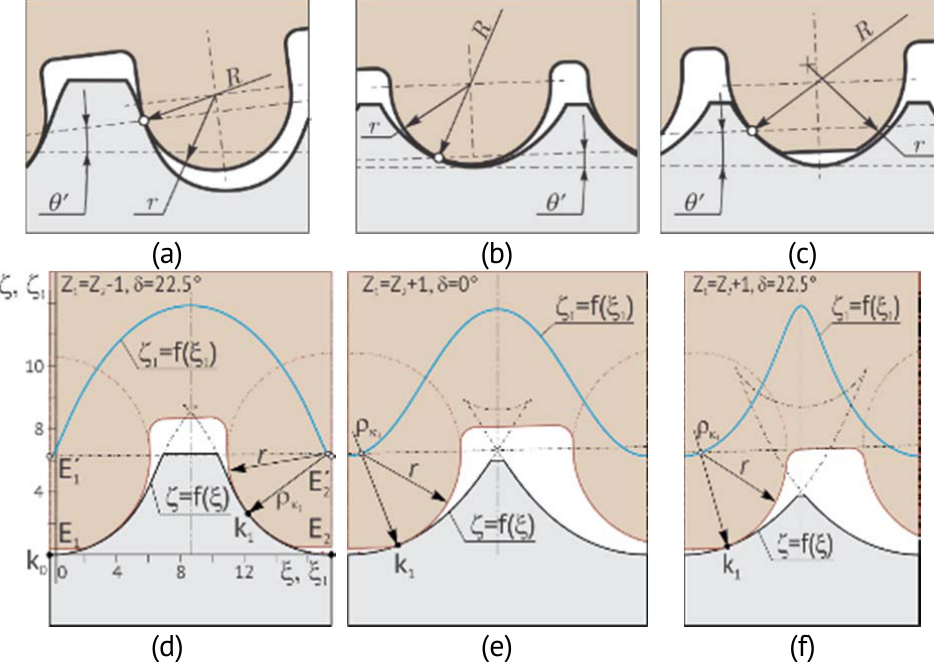
Figure 3. Geometry of teeth contact in the toothed precessional gear: a, b, c – contact with the profile of the teeth in the circular arc and convex / concave; d, e, f – convex-concave contact with small difference of the curvature radii of conjugated profiles for different ‒  ; ±1 ] parametric configurations [Z g